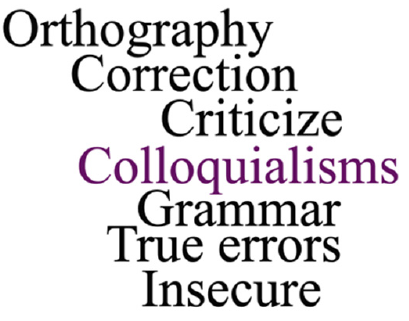
Figure 2. Common responses regarding student